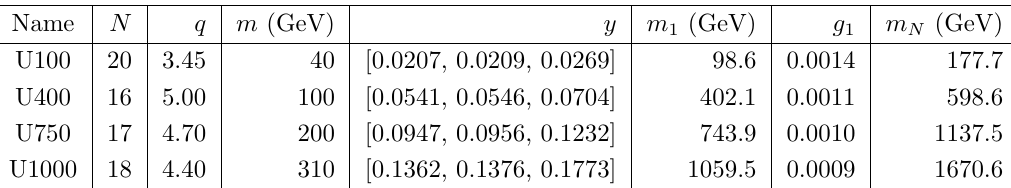
Table 1 . Benchmark points (BPs) for the uniform clockwork model. First column: BP name. Next 4 columns: model input parameters. Last 3 columns: mass of the lightest CW neutrino; its coupling to weak current; and mass of the heaviest CW neutrino.